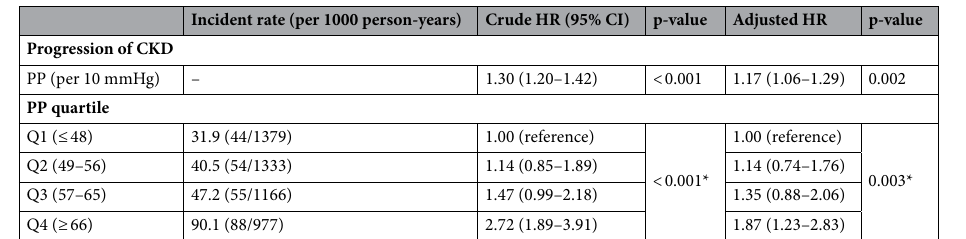
Table 2. Incidences and hazard ratios associated with pulse pressure quartile for progression of chronic kidney disease. PP Pulse Pressure, CKD Chronic kidney disease, HR Hazard ratio, CI confidence interval. Adjusted HRs were obtained, controlling for age, sex, BP-lowering medication, diabetes, dyslipidemia, hyperuricemia, obesity, smoking, drinking, and baseline eGFR and proteinuria. *p for trend.